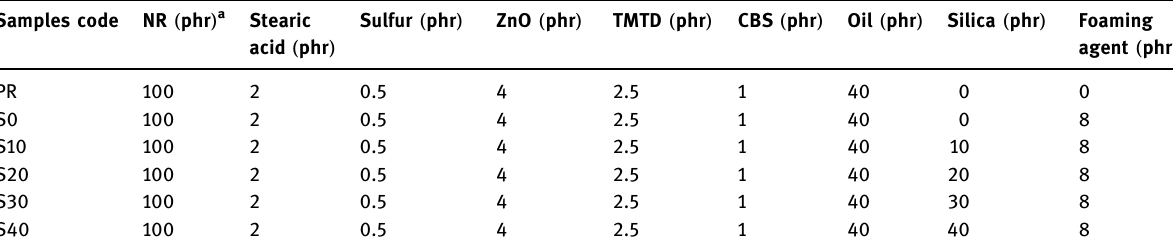
Table 1: Compositions of prepared samples Samples code NR ( phr ) a